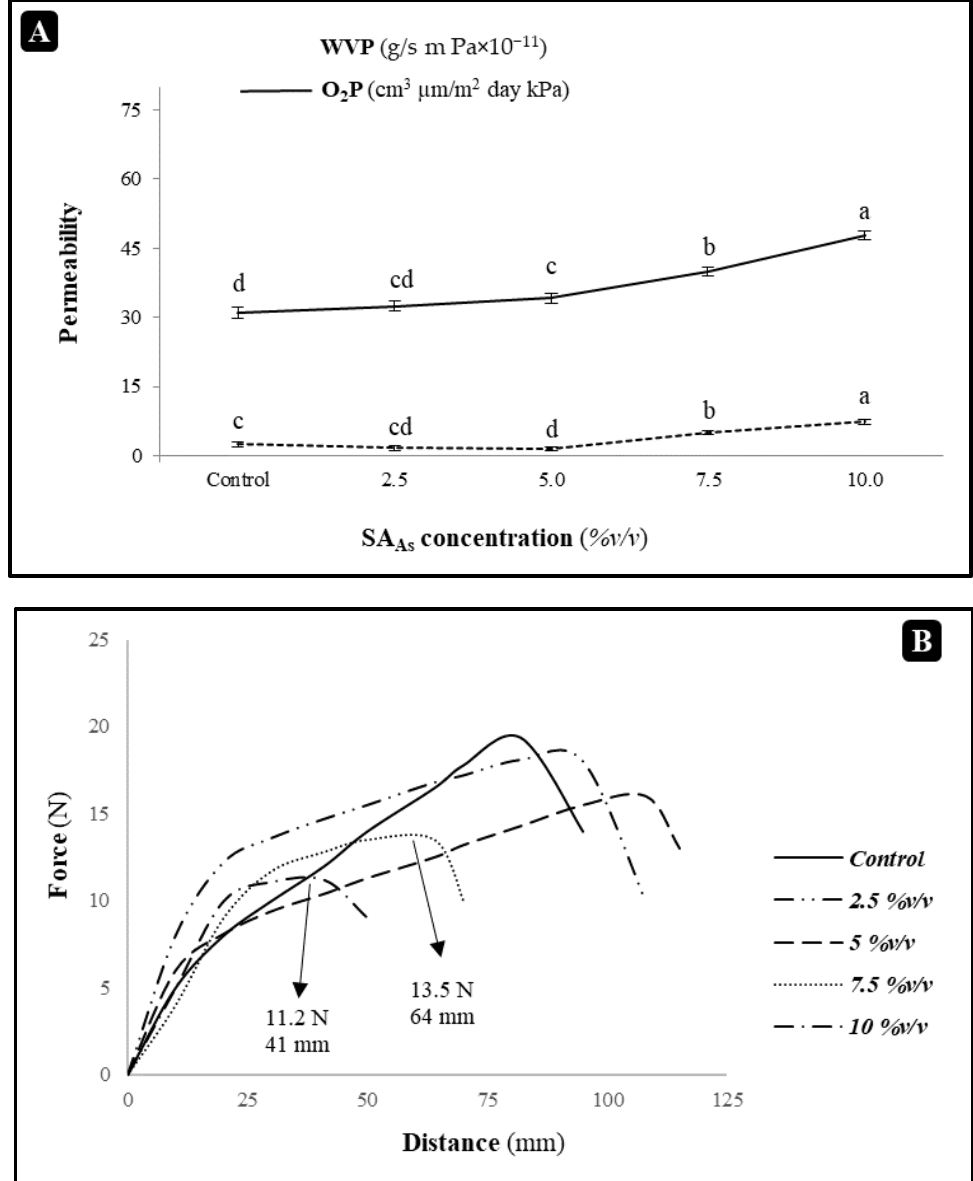
Figure 3. Effect of SA As concentrations on ( A ) mechanical and ( B ) mechanical properties of salep mucilage edible indicator films. g/s m Pa×10 − 11